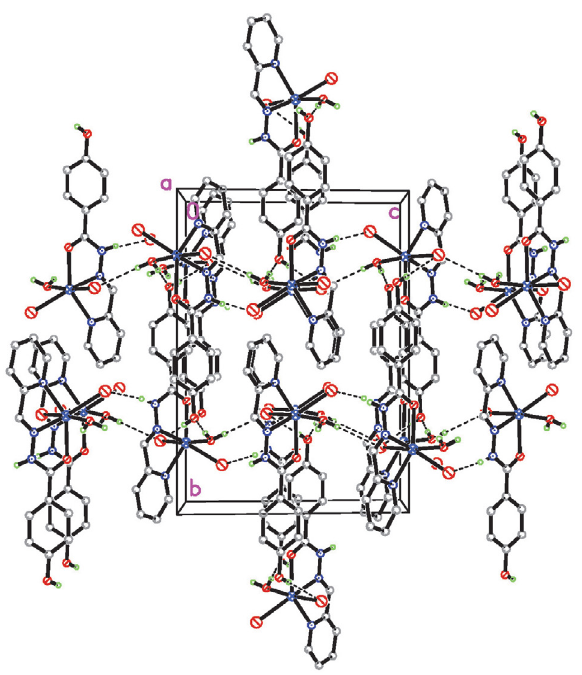
Figure 2. Molecular packing structure of complex 1 linked by hy- drogen